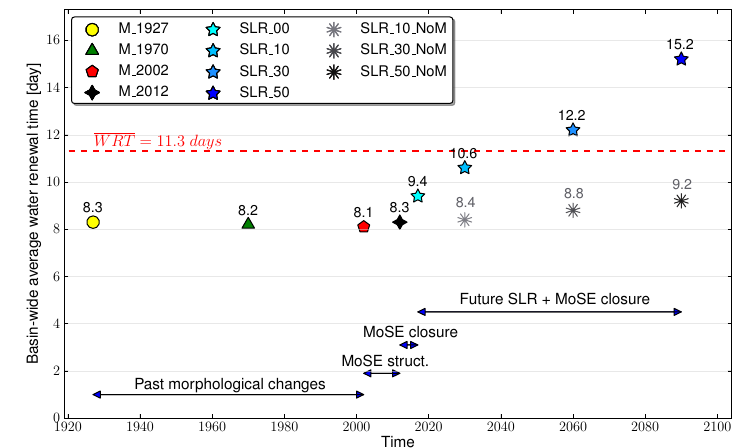
Fig. 7. Evolution of average water renewal time in the Venice Lagoon under fall–winter conditions considering past morphological changes, the MoSE structures, the closure of MoSE barriers during high tide events and future sea level rise of 10, 30 and 50cm. Gray asterisks indicate the results of SLR simulations without considering closure of the mobile barriers at the inlets (SLR 10 NoM, SLR 20 NoM, SLR 30 NoM). The red dashed line at WRT=11.3 days indicates the average yearly value of the present situation (2012, simulation Y